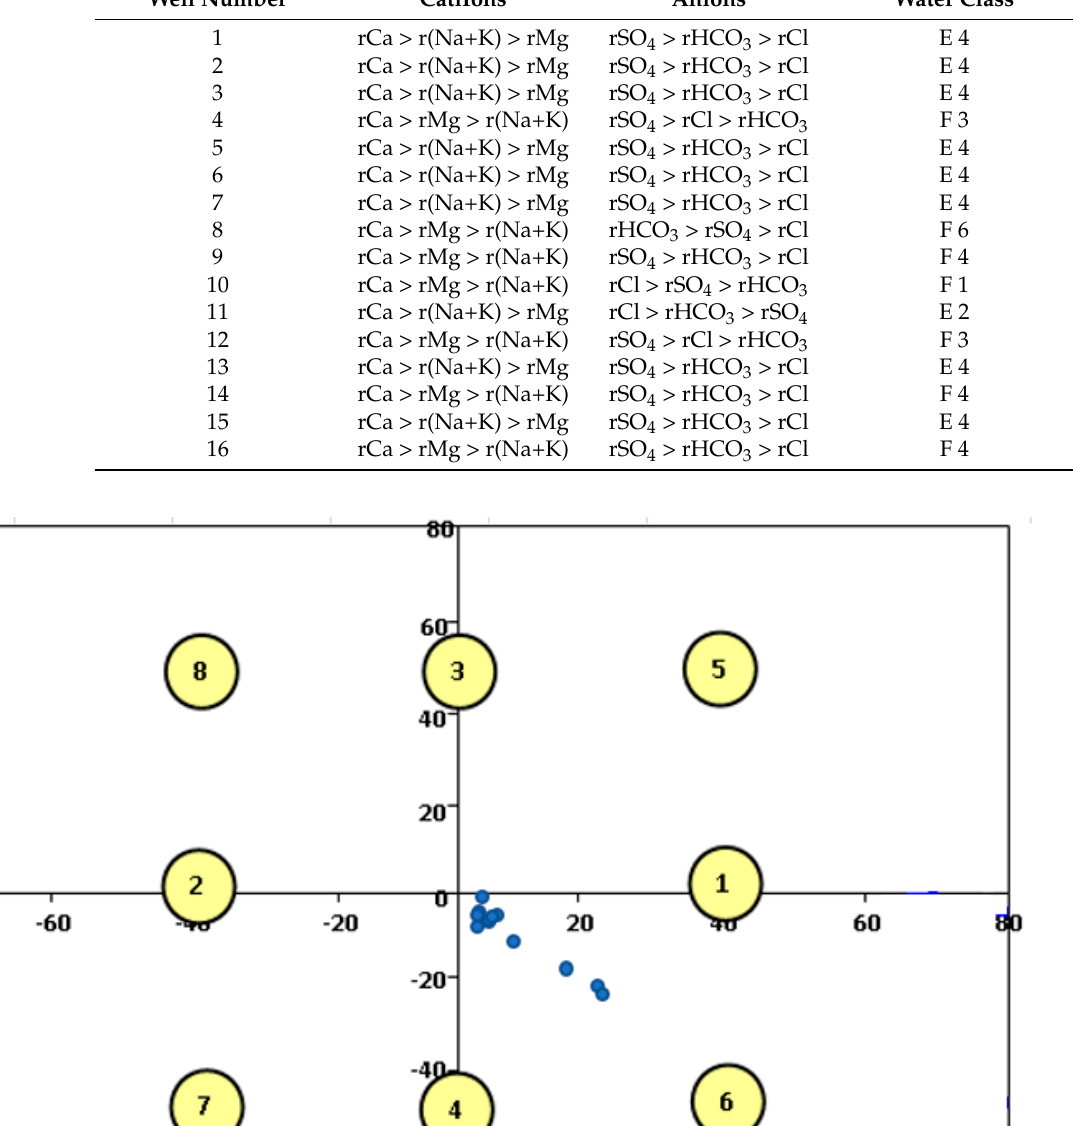
Table 10. Water class according to the Shoeller Classification of water samples.